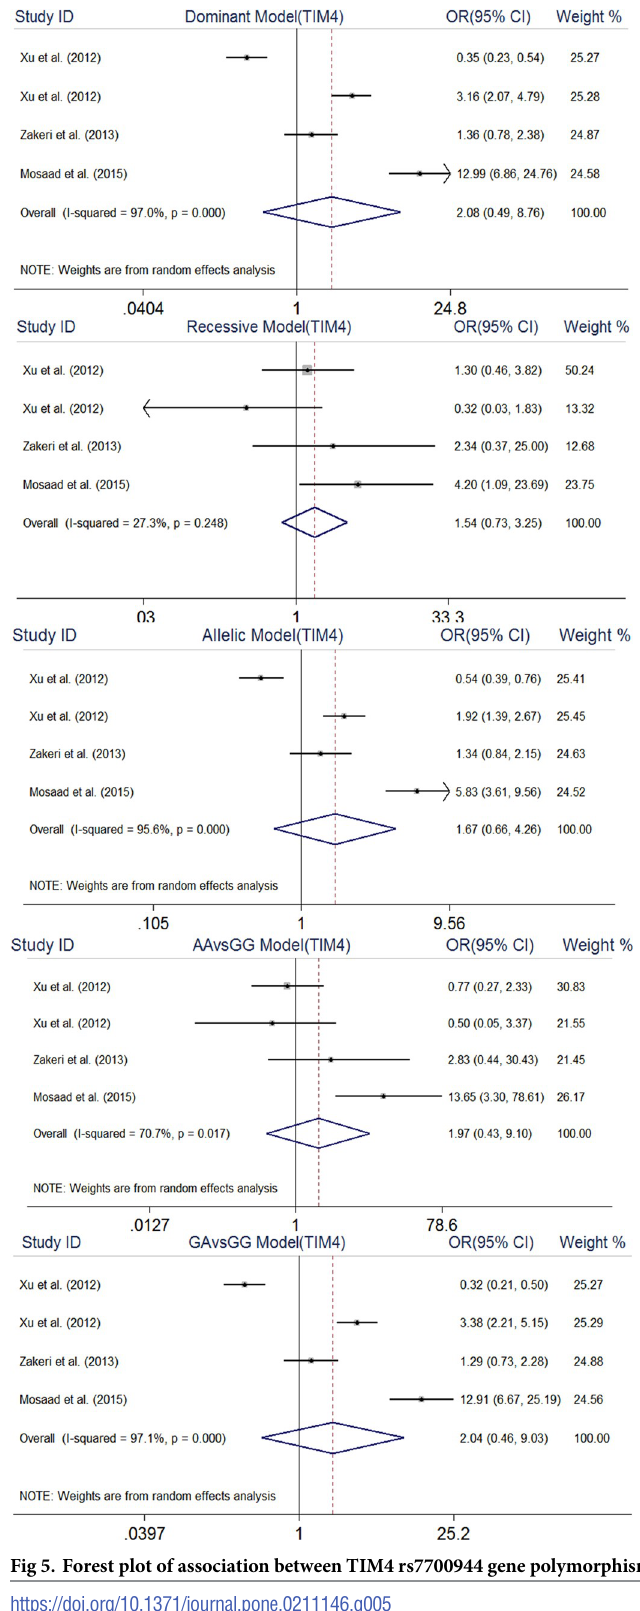
Fig 5. Forest plot of association between TIM4 rs7700944 gene polymorphism and rheumatoid arthritis.